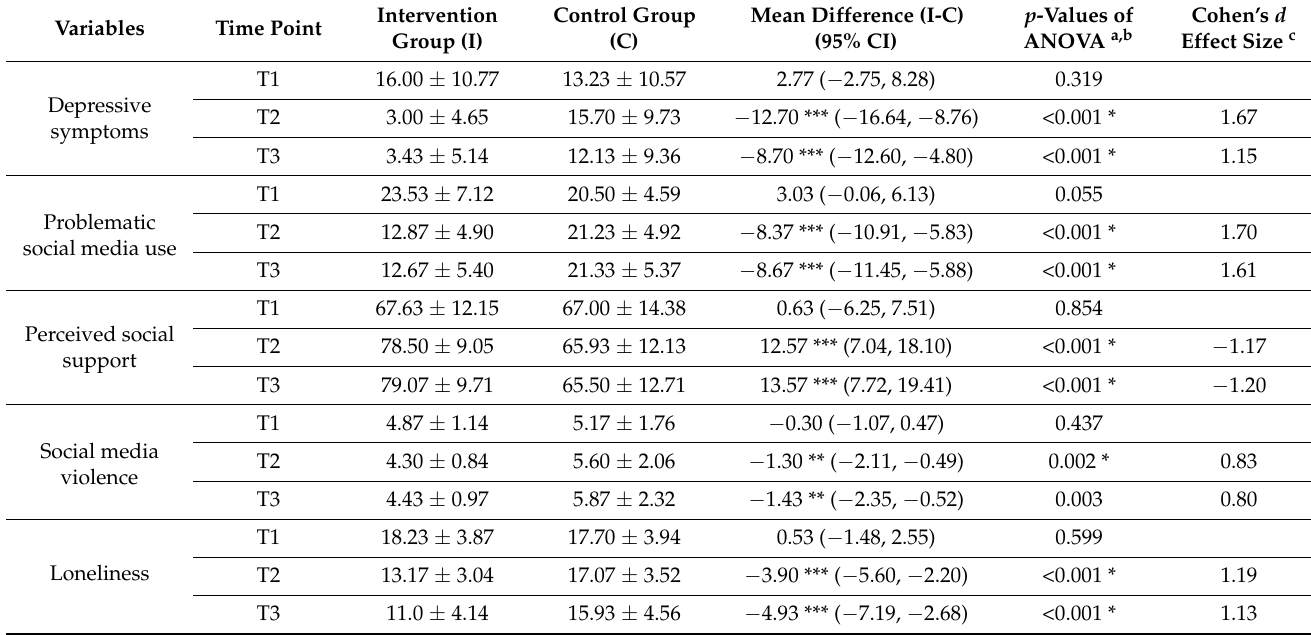
Table 6. Between-group difference of scores on depressive symptoms as well as problematic social media use, perceived social support, social media violence, and loneliness among college students in Shaanxi, China ( n =